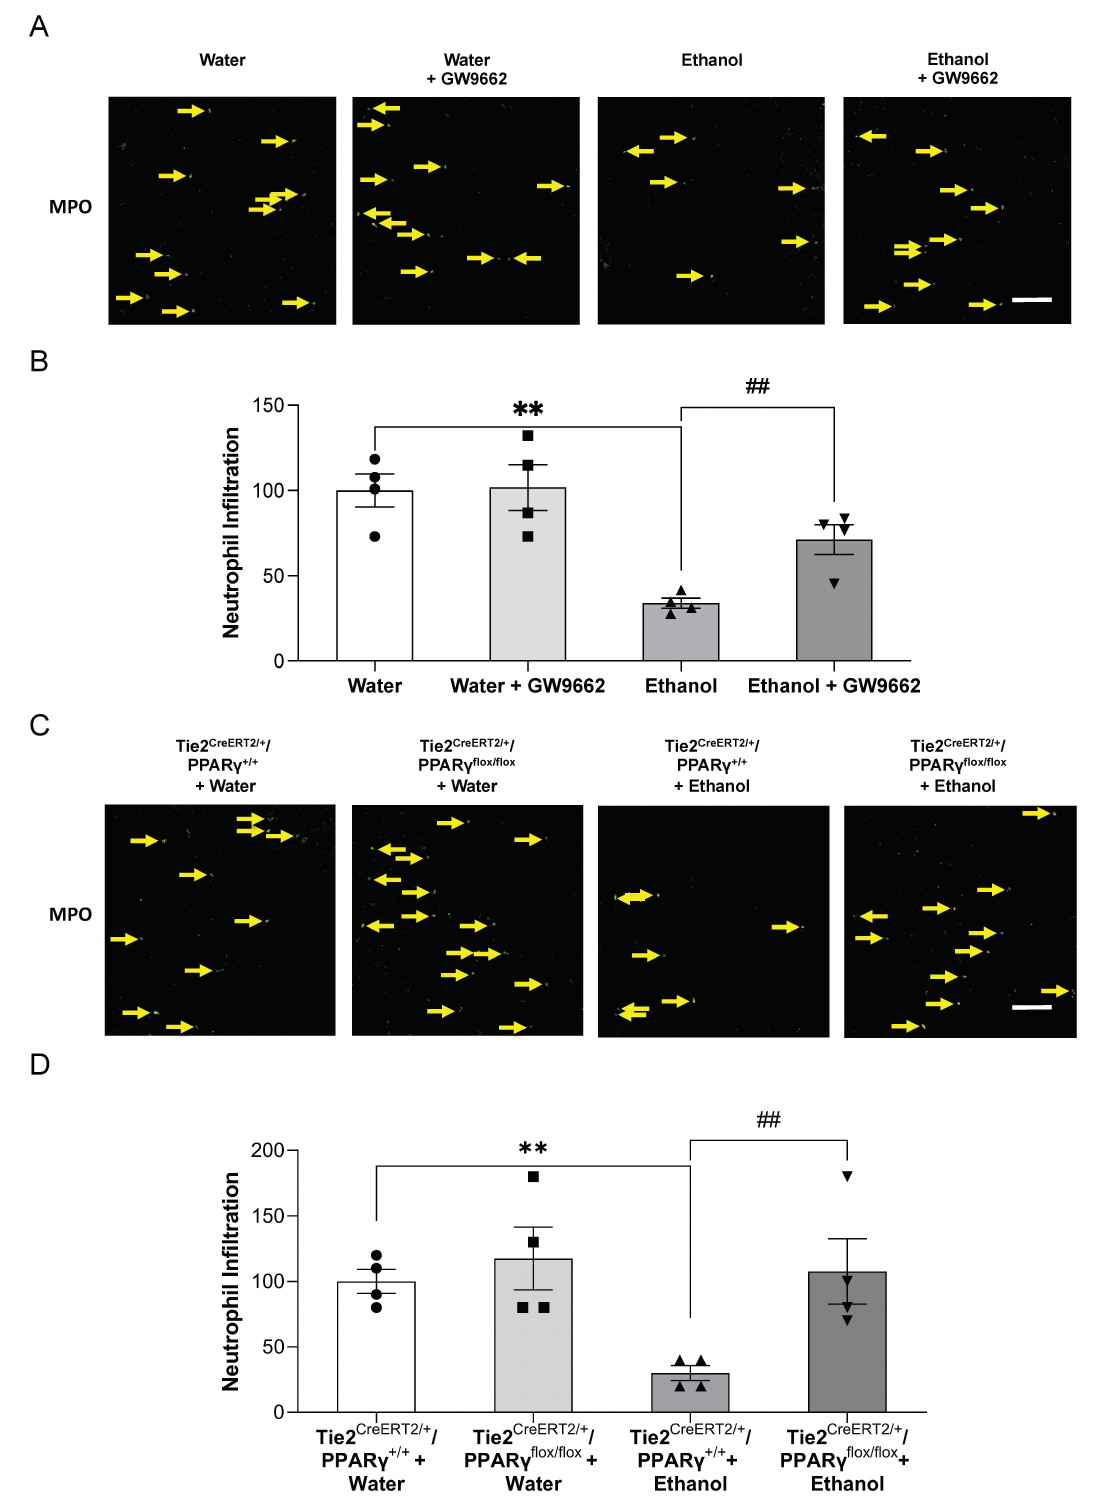
Figure 5. Effect of chronic ethanol consumption on neutrophil infiltration in the presence and absence of GW9662 and endothelial-specific conditional PPAR γ knockout. ( A , C ) Representative immunohistochemistry staining of MPO (scale bar = 100 µ m). ( B , D ) Values are means ± SE. ** p < 0.05 vs. Water or Tie2 CreERT2/+ /PPAR γ +/+ + Water. ## p < 0.05 vs. Ethanol or Tie2 CreERT2/+ /PPAR γ +/+ + Ethanol. Analyzed using two-way ANOVA with Tukey’s post